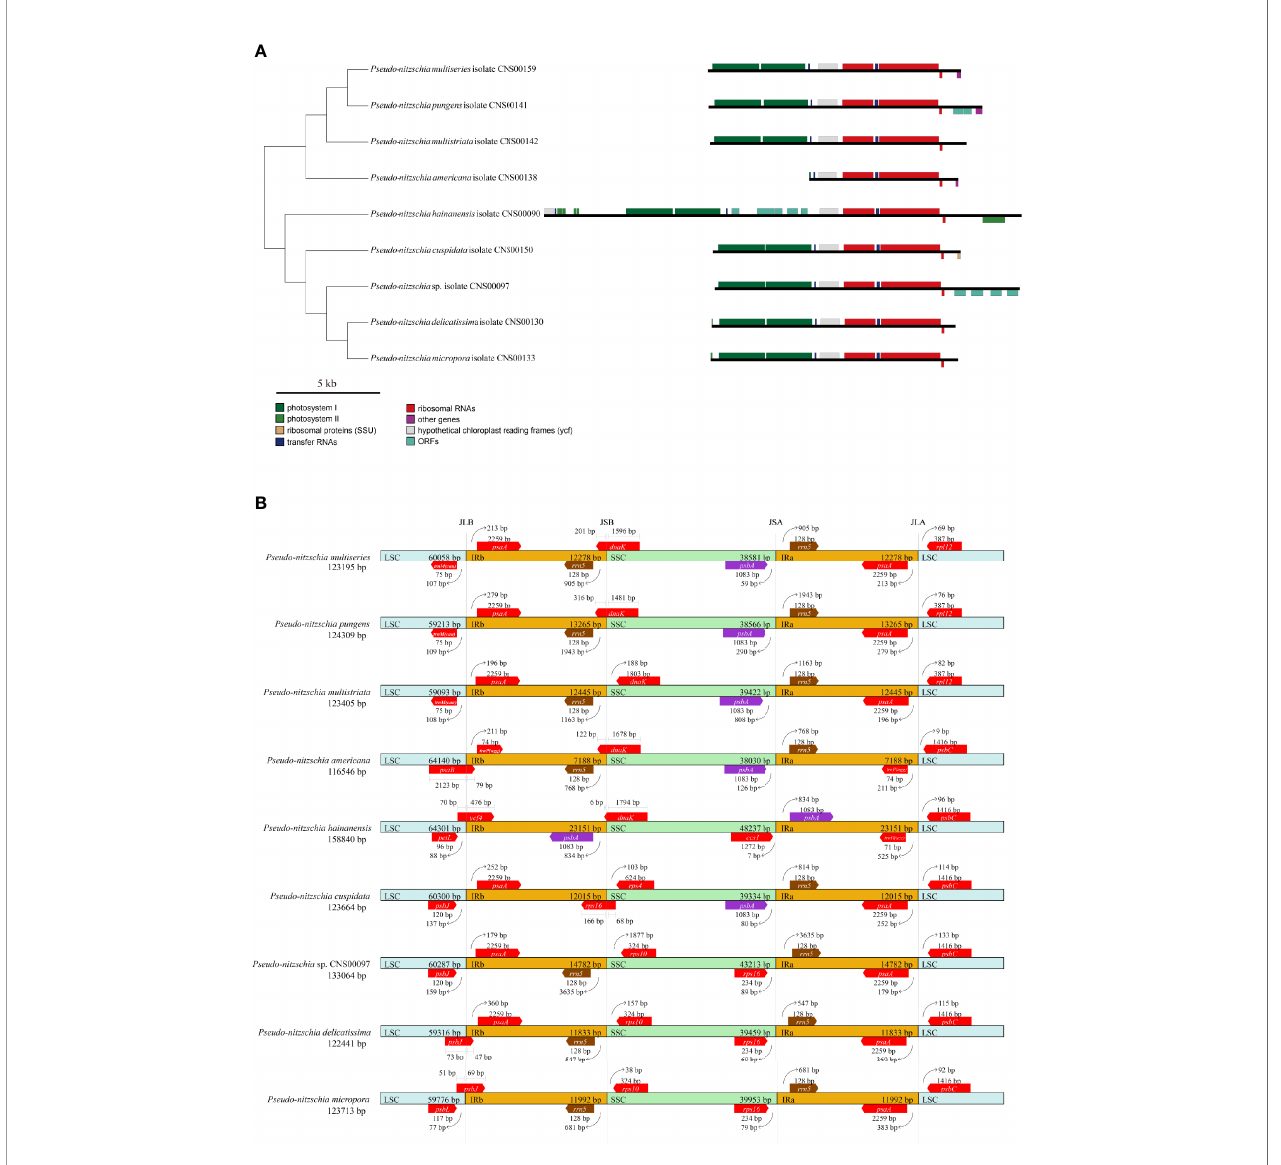
FIGURE 6 | Comparison of the Inverted Repeat region among the nine Pseudo-nitzschia cpDNAs (A) . The topology tree on the left were constructed based on phylogenetic tree of cpDNAs. Genes were colored based on their functional groups. Comparison of the junction sites between the Long Single Copy (LSC), Short Single Copy (SSC) and Inverted Repeat (IRa and IRb) regions among the nine Pseudo-nitzschia cpDNAs (B) . JLB (IRb/LSC), JSB (IRb/SSC) JSA (SSC/IRa) and JLA (IRa/LSC) denote the junction sites between each corresponding region on the